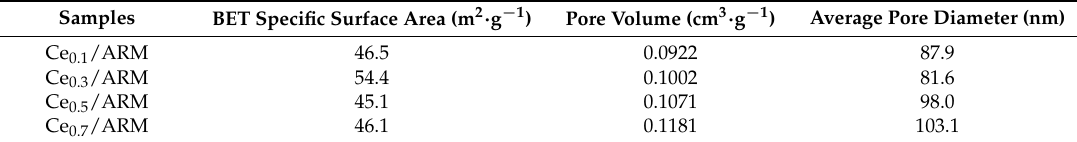
Table 3. BET surface areas, pore volumes and average pore diameter of Ce/ARM catalysts. Samples